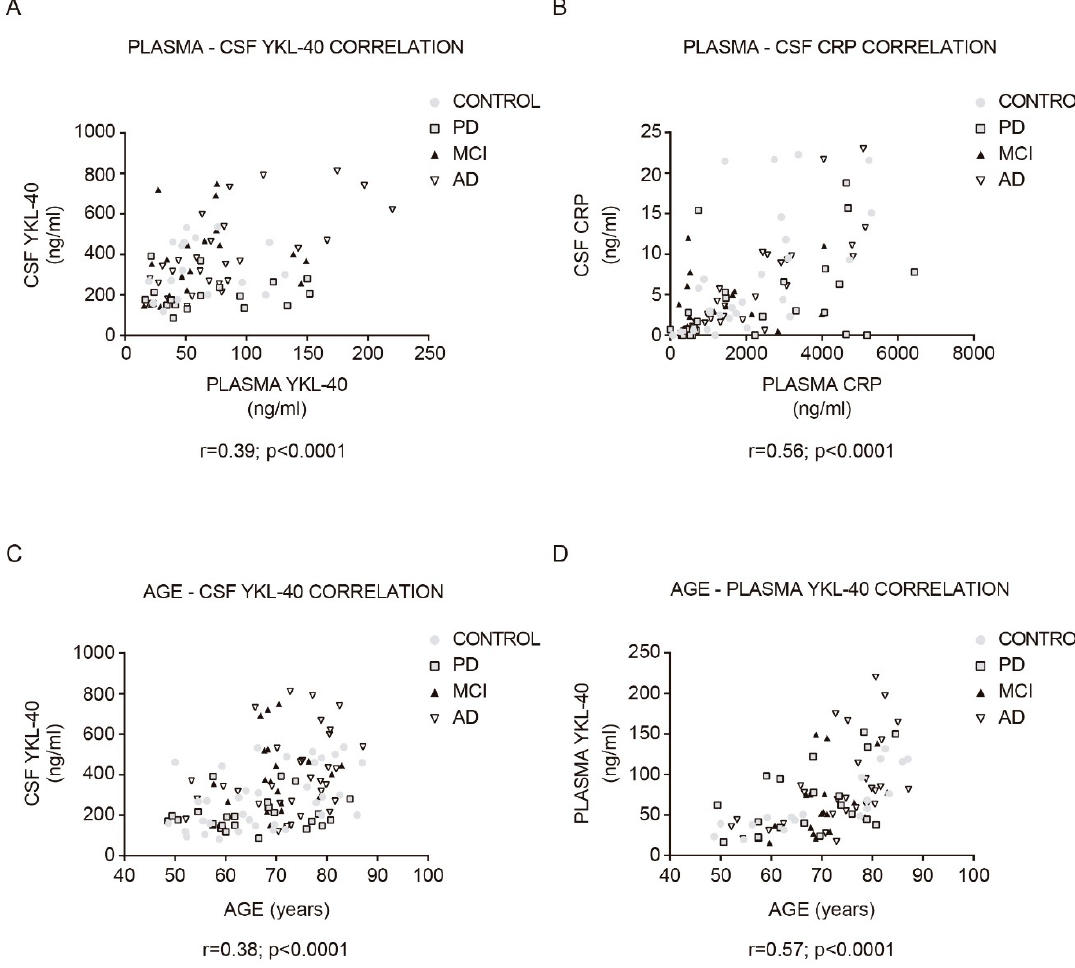
Figure 3. Correlation between YKL-40 and CRP levels in CSF and plasma, and between YKL-40 and age in the study cohort. Correlations between the expression levels of ( A ) YKL-40 and ( B ) CRP in CSF and plasma in the study cohort. Correlation between ( C ) CSF and ( D ) plasma YKL-40 and age within the diagnostic group. Correlations were examined with Pearson correlation test. MCI, mild cognitive impairment; AD, Alzheimer’s disease dementia; PD, Parkinson’s dis- ease.